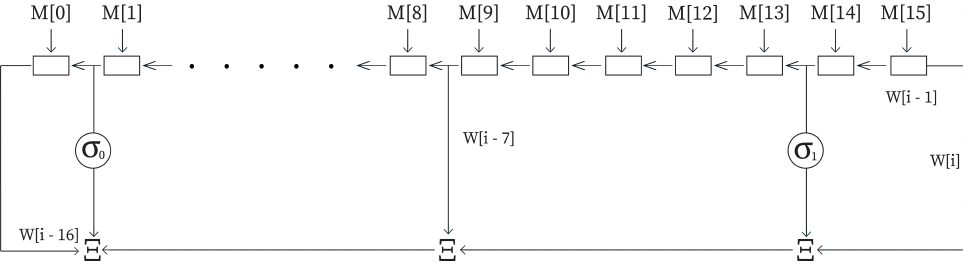
Figure 4. The SHA-512 message